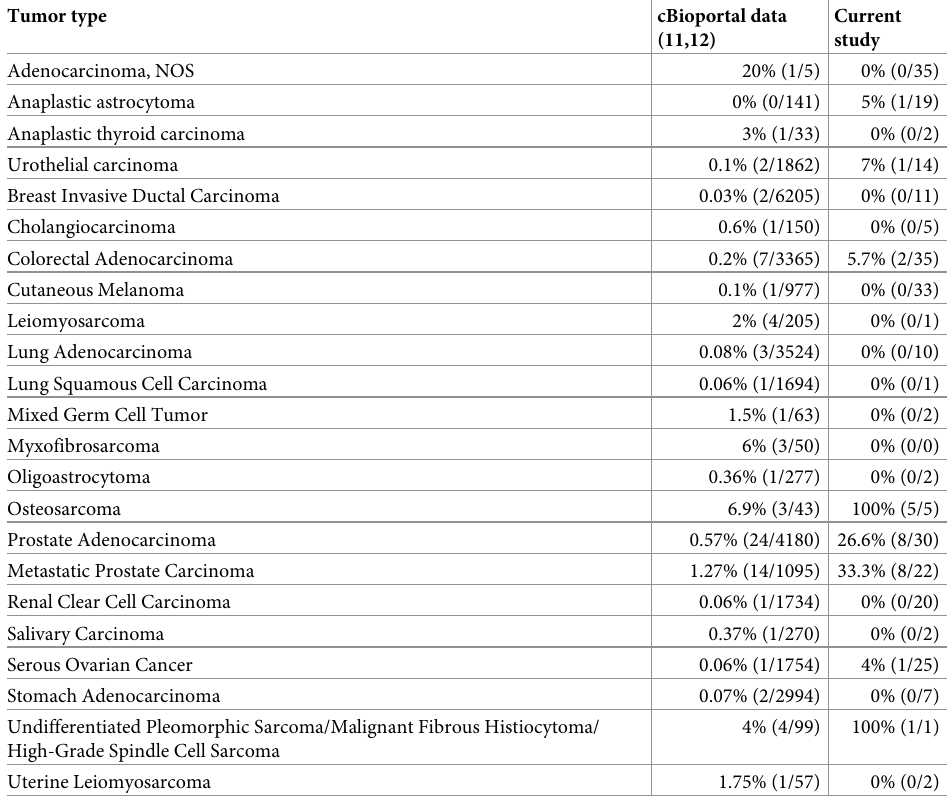
Table 1. Distribution of TP53 fusions across different